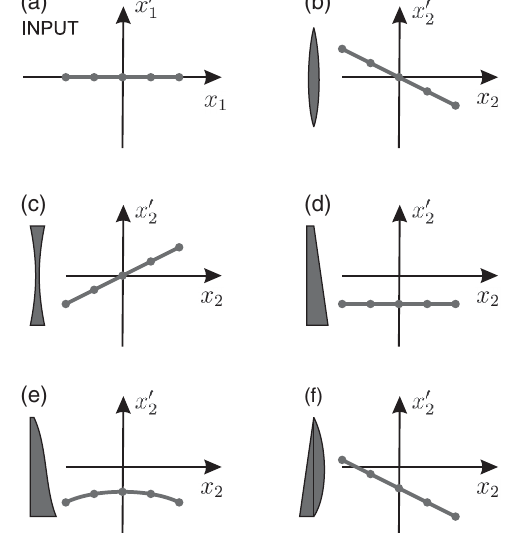
FIG. 5. The transfer properties of simple optical elements: (a) The assumed set of input pairs ð x 1 ; x 0 1 Þ , representing incident rays with various positions and zero slopes. (b) – (f) Calculated ð x 2 ; x 0 2 Þ at the exit of (b) converging lens, (c) diverging lens, (d) linear prism, (e) nonlinear prism, (f) converging lens with off-axis focus. Linear transfer functions describe (a) – (c), for (d), (f) an affine function is needed, while for (e) a nonlinear transfer function must be